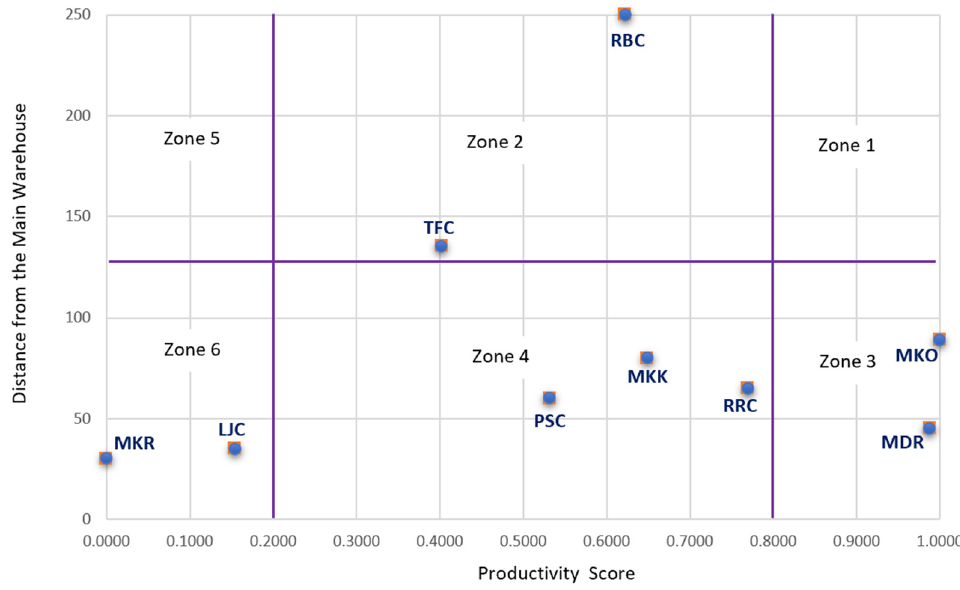
Figure 3. DC zone identification based on their locations and productivity scores.